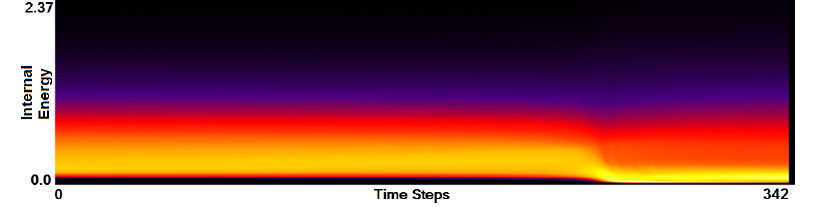
Figure 10. Result of automatic function plot synchronization for the astrophysical multi-run simulation data. As opposed to the unsynchronized representation in Figure 9, details of the general structure (three phases) can be